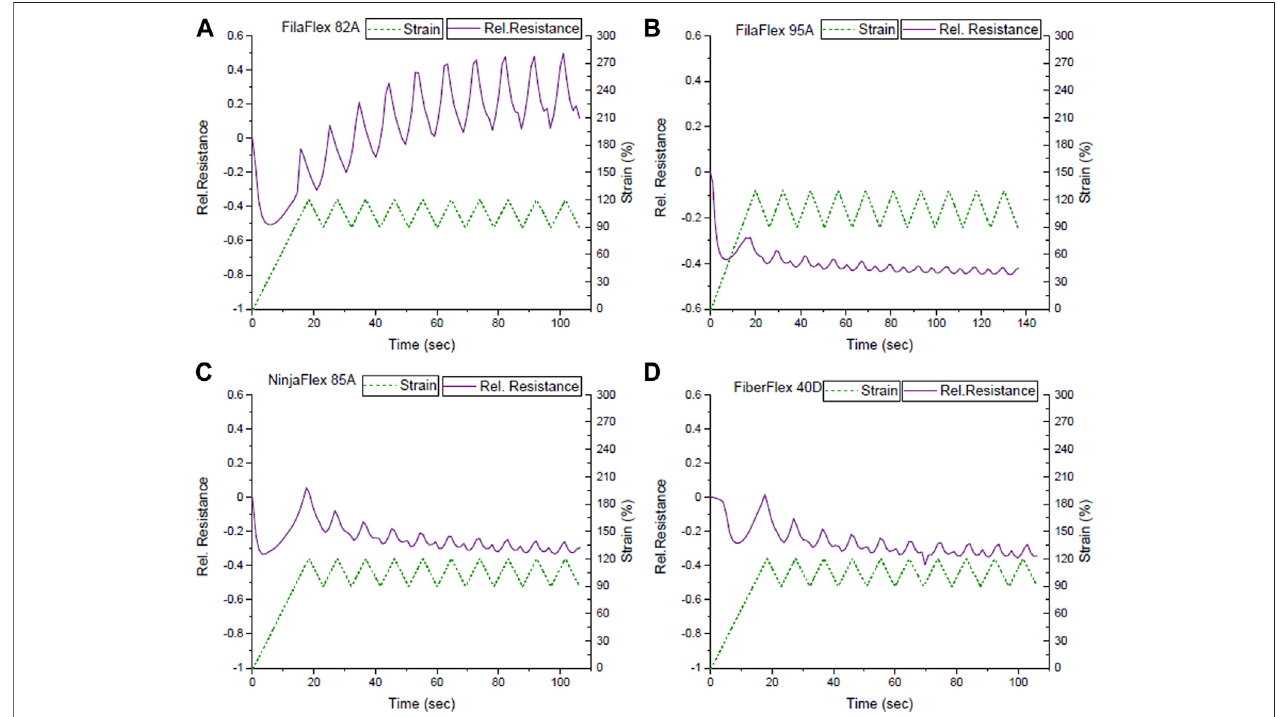
FIGURE 6 | Sensor response during dynamic tensile test between the strains 90 and 120% for the TPU strips with integrated strain sensing elements from (A) FilaFlex 82A, (B) FilaFlex 95A, (C) NinjaFlex 85A, (D) FiberFlex 40D.